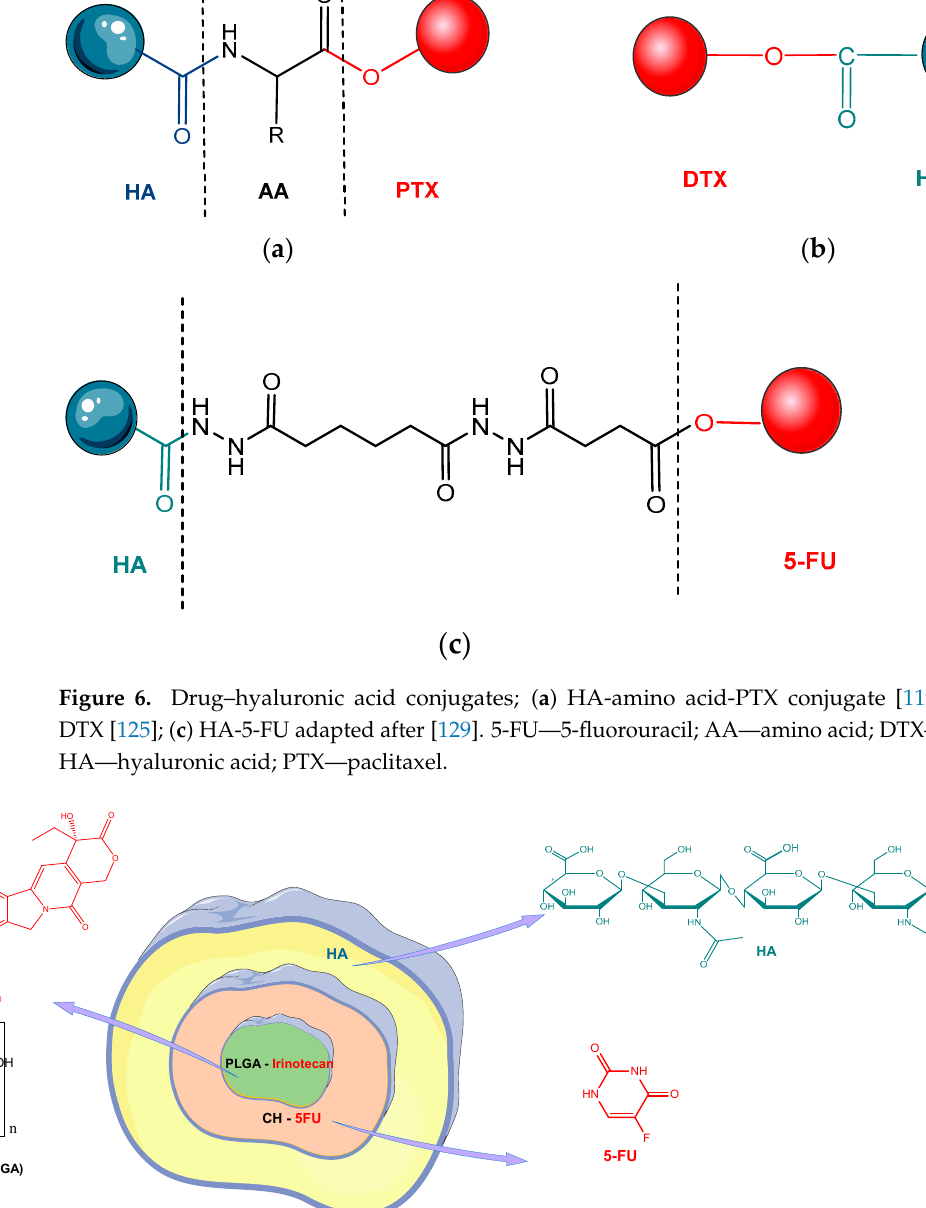
Figure 6. Drug–hyaluronic acid conjugates; ( a ) HA-amino acid-PTX conjugate [119]; ( b ) HA-DTX [125]; ( c ) HA-5-FU adapted after [129]. 5-FU—5-fluorouracil; AA—amino acid; DTX—docetaxel; HA—hyaluronic acid; PTX—paclitaxel.